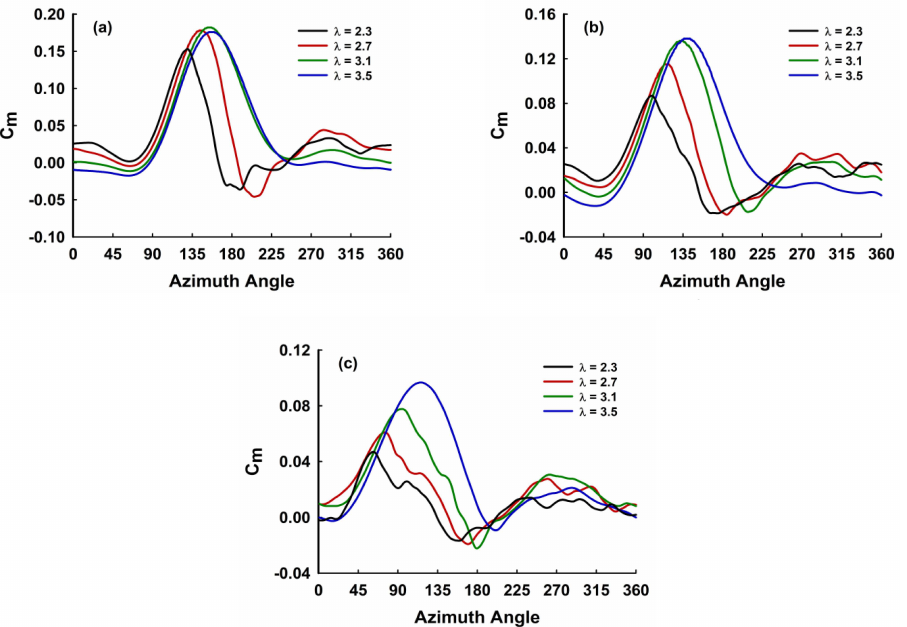
Figure 8. Moment coefficient for various tip speed ratios (TSRs), ( a ) helix angle 60 ◦ , ( b ) helix angle 90 ◦ , ( c ) helix angle 120 ◦